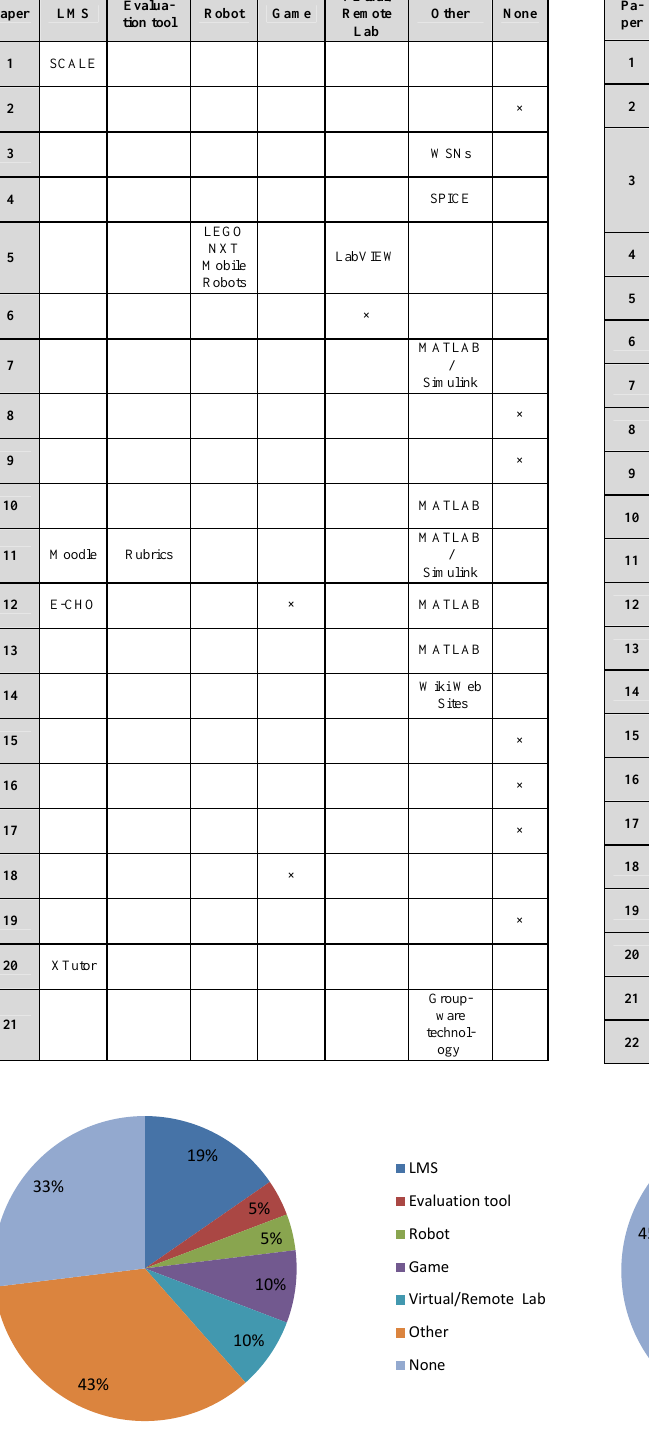
TABLE IV. T ECHNOLOGY T OOL D IMENSION , AEE V OL . 2, N. 3 AND 4